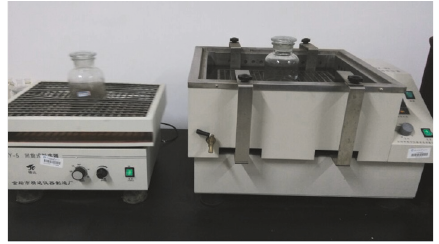
Figure 1: Experiment device of static leaching.